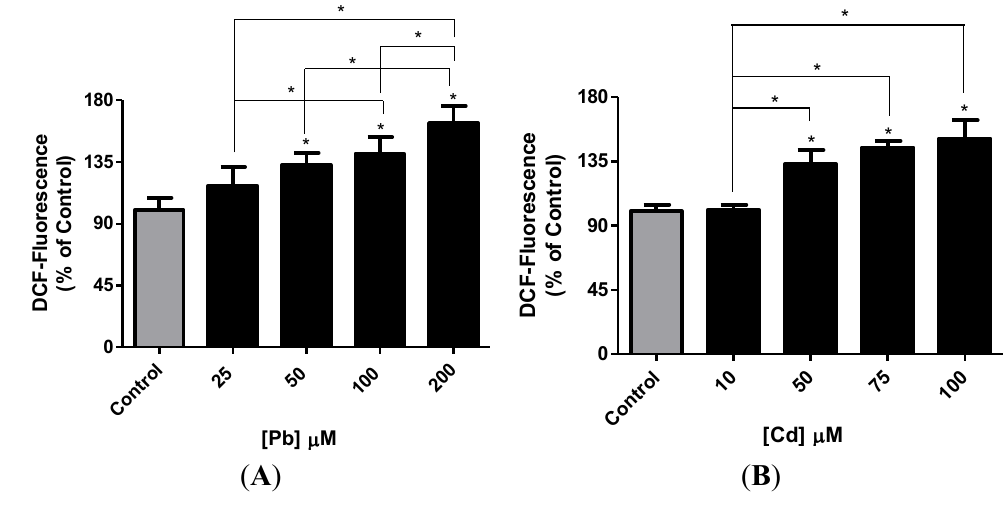
Figure 2. ROS levels in hCMEC/D3 cells after treatment with ( A ) Pb and ( B ) Cd. ROS levels were measured after 1 h of treatment. All experiments were performed in quadruplets, and the values reported are mean ± SD ( * over the test column represents p < 0.05 compared to the control, and on the linking lines represents p < 0.05 between the two test